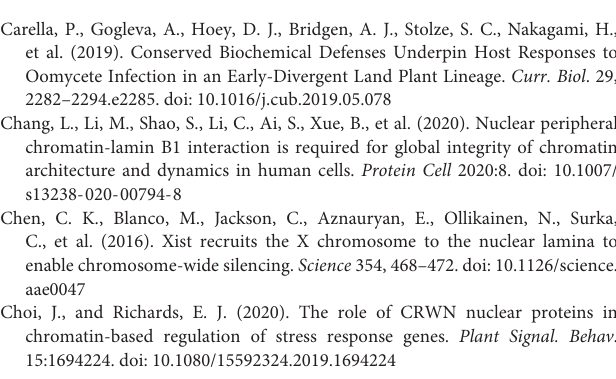
Supplementary Figure 1 | Sequence alignment of NMCP homologs. Supplementary Figure 2 | RNA-seq analysis of Mpnmcp mutant lines. Supplementary Figure 3 | Relative expression of selected jasmonate marker genes. Supplementary Figure 4 | Perinuclear localization of a V chromosome region. Supplementary Figure 5 | FISH experiment of the entire V-chromosome. Supplementary Figure 6 | Genome-wide Hi-C maps of WT Tak-1 and Mpnmcp mutant thalli. Supplementary Figure 7 | Comparison of chromatin organization patterns of autosomes in WT Tak-1 and Mpnmcp mutants. Supplementary Figure 8 | Western blot confirms MpNMCP-2HA protein IP. Supplementary Figure 9 | Fluorescence-activated cell sorting (FACS) of 8C nuclei. Supplementary Figure 10 | Thalli area measurements of WT Tak-1, Mpnmcp mutants and Mpnmcp complementation lines. Supplementary Figure 11 | Semi-quantitative RT-PCR showing the expression of MpNMCP in the crwn1 crwn2 35S:MpNMCP-2HA plants. Supplementary Table 1 | Read count and DEGs tables. Supplementary Table 2 | Sequences of primer pairs used in this study. Supplementary Data Set 1 | The NMCP sequences used to reconstruct Supplementary Figure 1